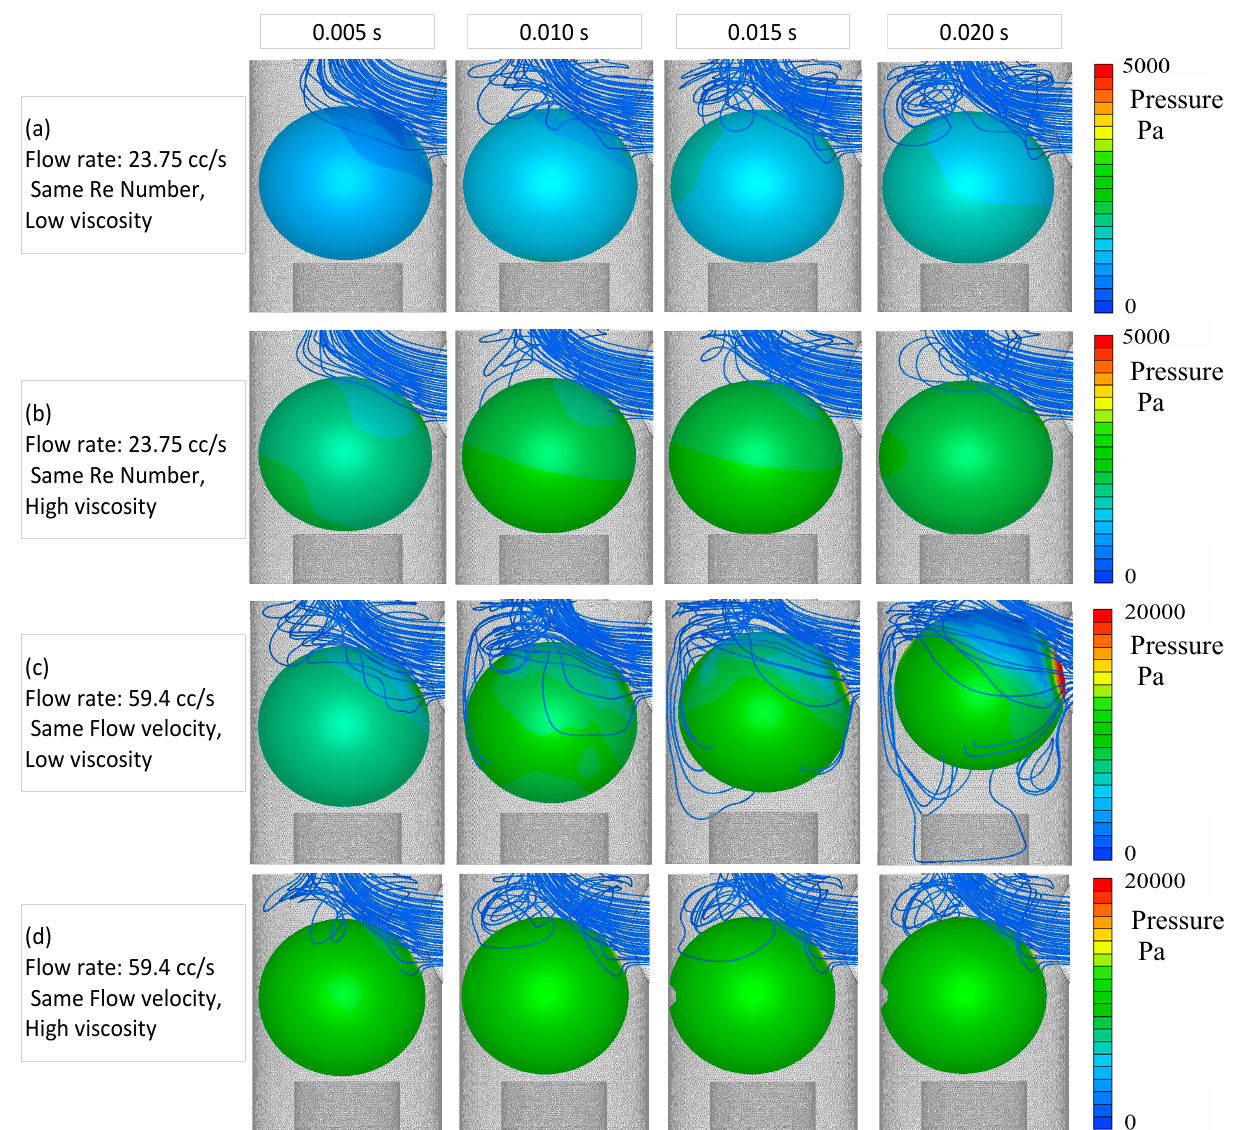
Figure 10. Time variation of lift for low-viscosity case with three degrees of freedom of Model (b): ( a ) Flow rate: 23.75 cc/s, Same Re Number, Low viscosity; ( b ) Flow rate: 23.75 cc/s, Same Re Number, High viscosity; ( c ) Flow rate: 59.4 cc/s, Same Flow velocity, Low viscosity; ( d ) Flow rate: 59.4 cc/s, Same Flow velocity, Low viscosity.